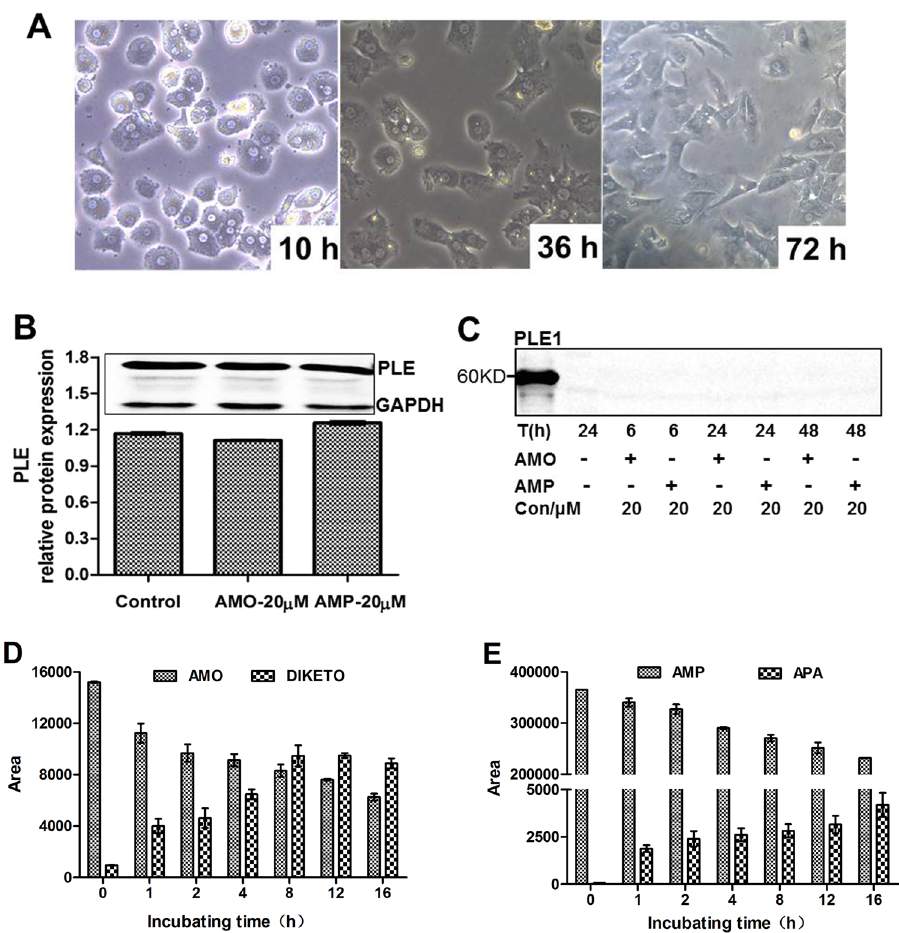
of pig hepatocytes lysate treated with AMO or AMP (20 µ M) for 24 h. Control was pig hepatocytes without any treatment. ( C ) Western blotting analysis of supernatants of pig hepatocytes treated with AMO or AMP (20 µ M). ( D,E ) LC-MS/MS detection of supernatants of pig hepatocytes treated with AMO or AMP (20 µ M). All assays were performed in triplicate with three transfection experiments and the hydrolytic activities are expressed as the mean ±